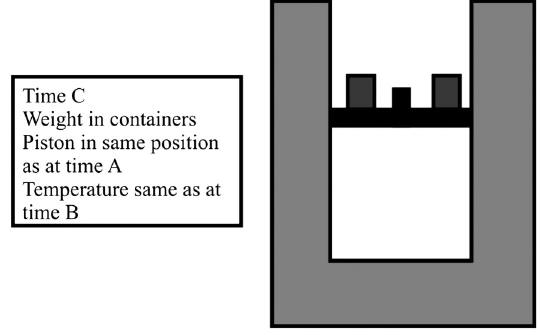
FIG. 6. The ideal gas system at time C.